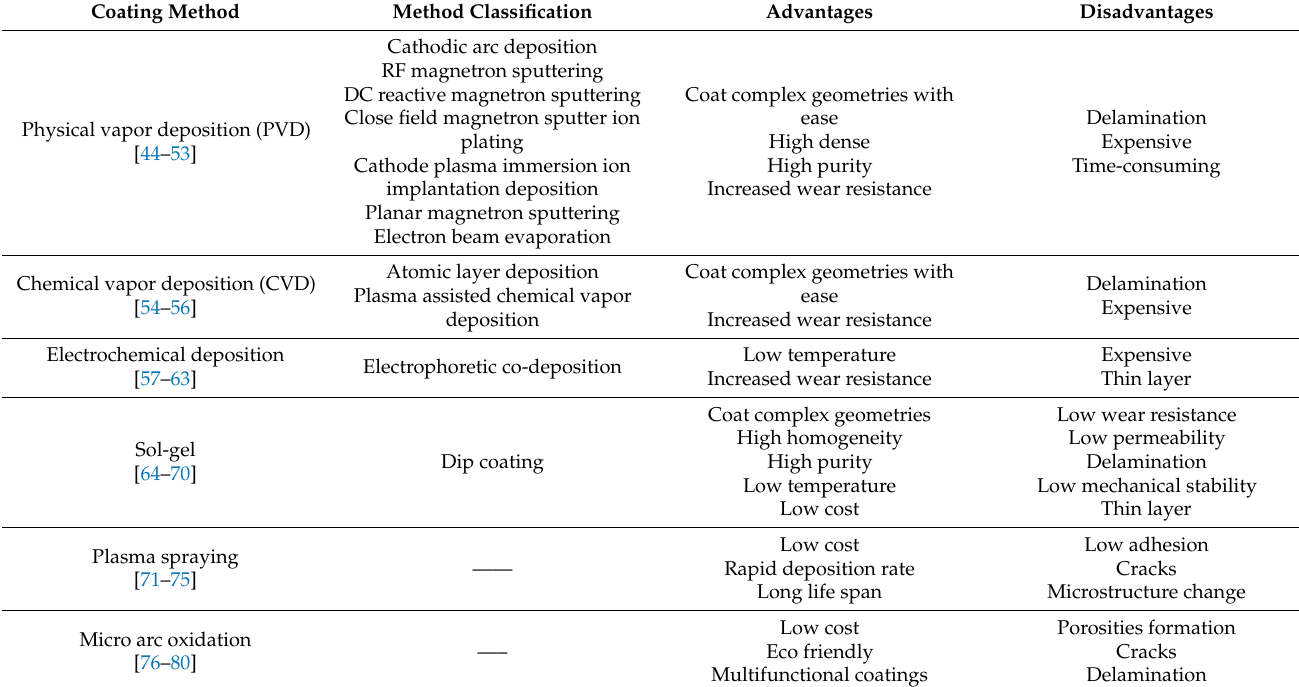
Table 2. Most common coating techniques for implant material